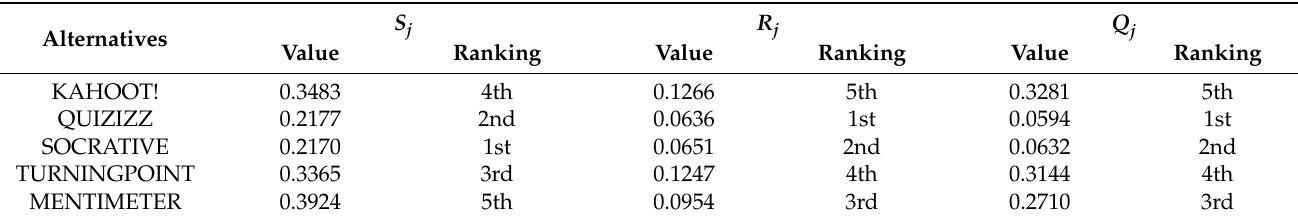
Table 15. Comparison of ranking with different MCDA techniques using objective weights from fuzzy Shannon entropy and subjective weights from MACBETH and W S = 0.5 and W O =